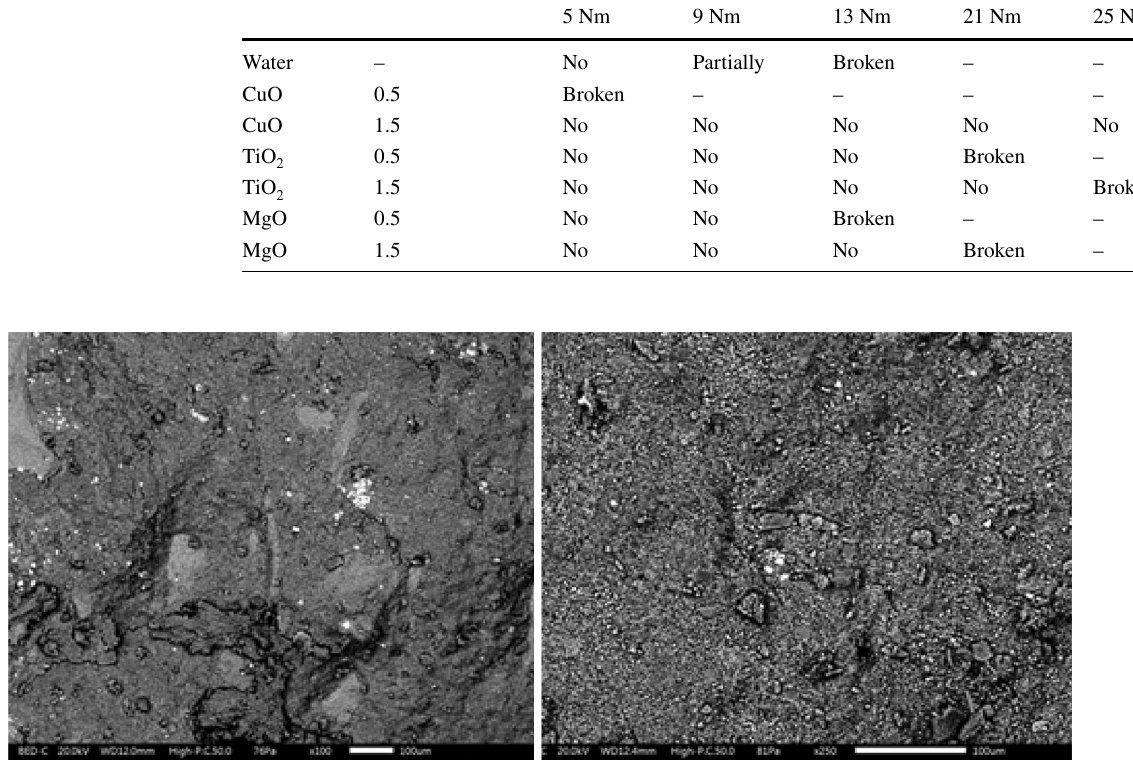
Fig. 7 SEM image of the shale sample before exposer to